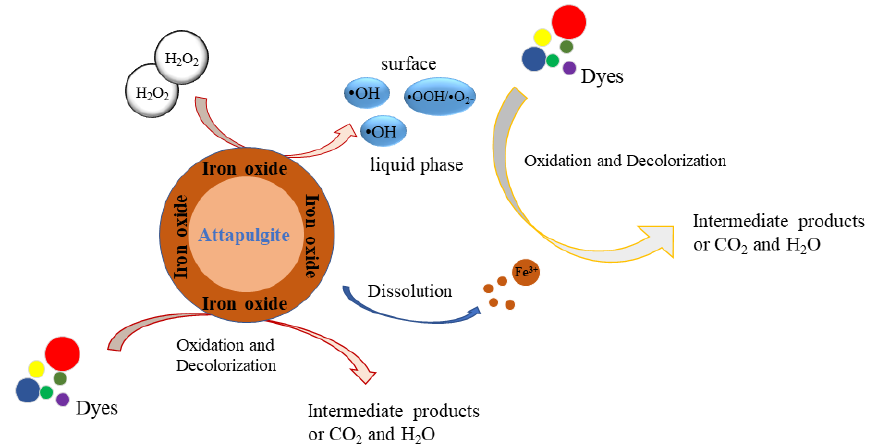
Figure 12. Proposed catalytic mechanism of dye decolorization and oxidation in the system.